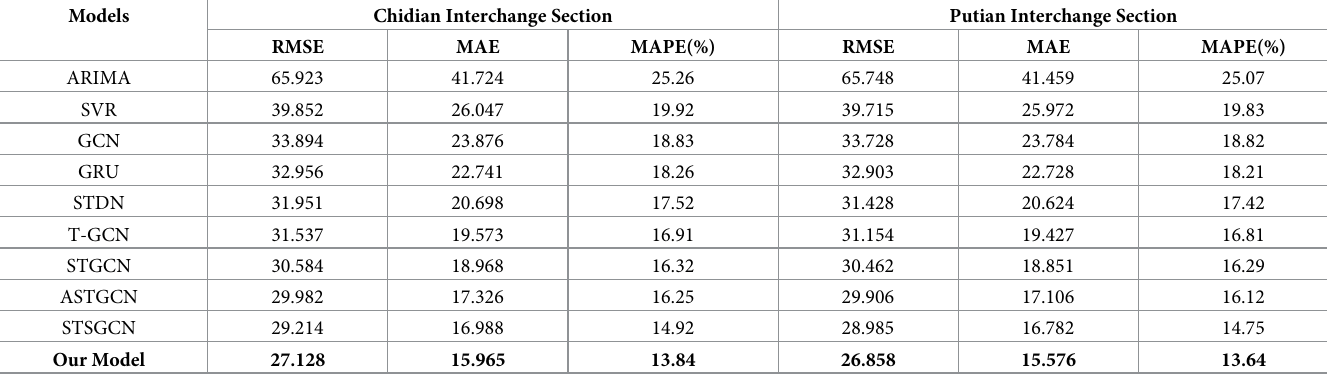
Table 5. Comparison of prediction results between Chidian Interchange Section and Putian Interchange Section.